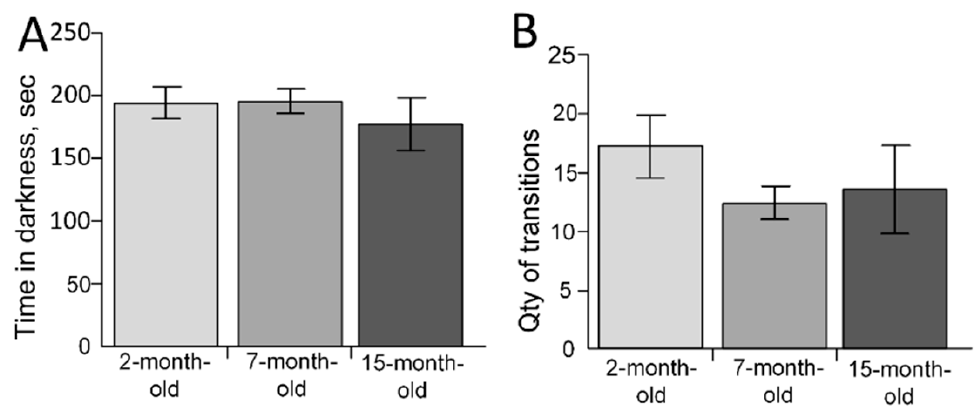
Figure 5. The results of the dark-light box test. ( A ) Time in the dark compartment of the box (s); ( B ) Number of transitions between compartments of the box. The 2-month-old mice (n = 9), 7-month- old mice (n = 9), 15-month-old mice (n = 9).